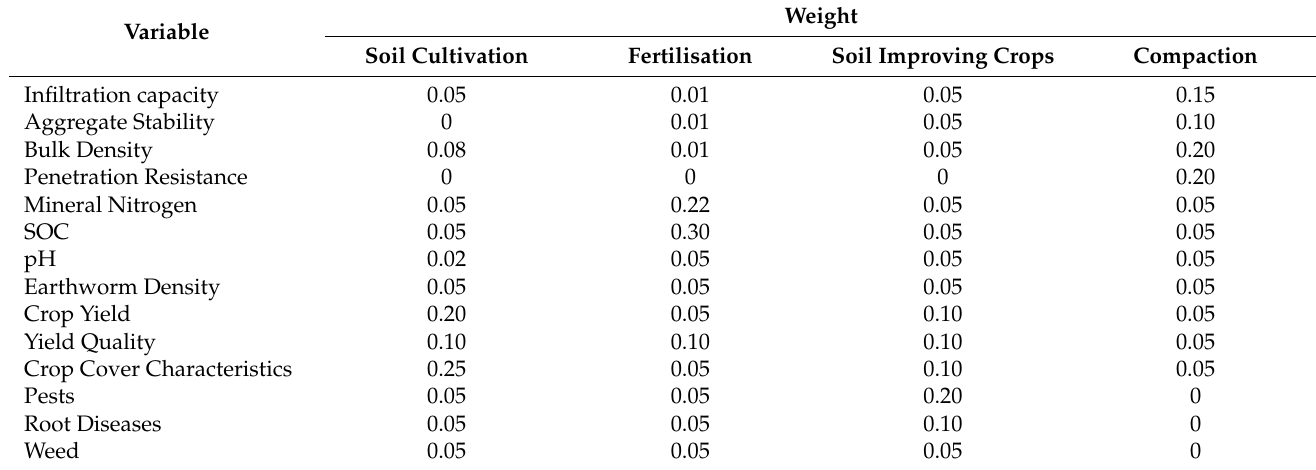
Table 1. Weighing factors attributed to variables as related to the four key topics (soil cultivation, soil fertilization, soil-improving crops, and soil compaction).